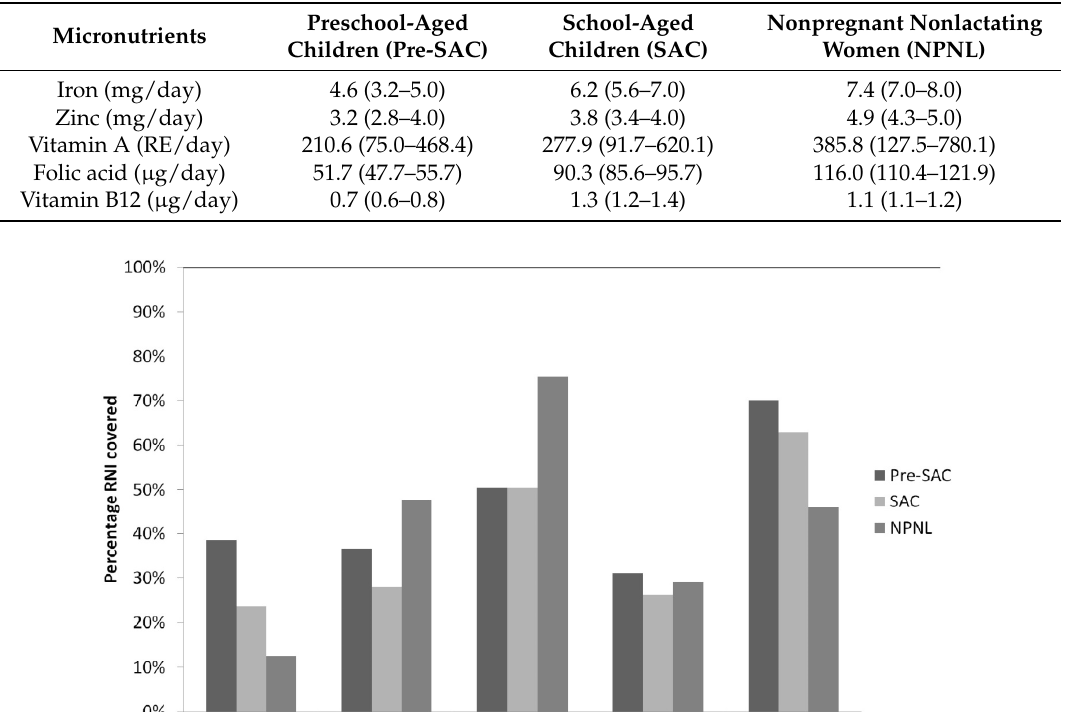
Table 2. Mean (95% confidence interval, CI) micronutrient intake by population group per capita.